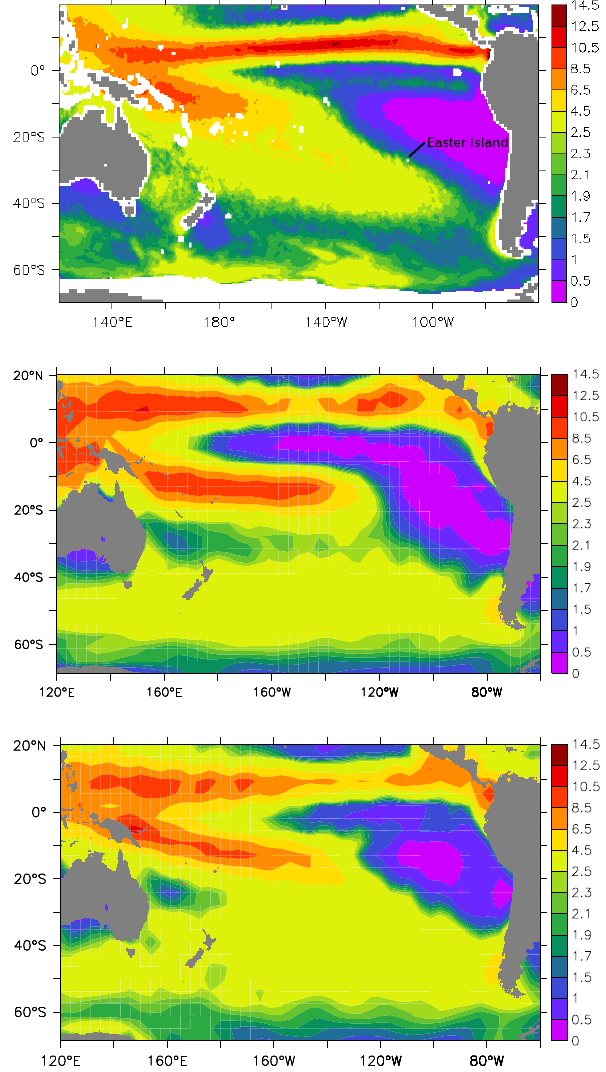
Fig. 1. Climatological mean of the precipitation rates [mm/d] in the Pacific region: (top) HOAPS-3 data for the period 1987–2005, (middle) ensemble mean of the Millennium experiments mil0010 , mil0012 and mil0013 for the period 1987–2005, (bottom) ensemble mean of the ECHO-G experiments Erik1 and Erik2 for the period